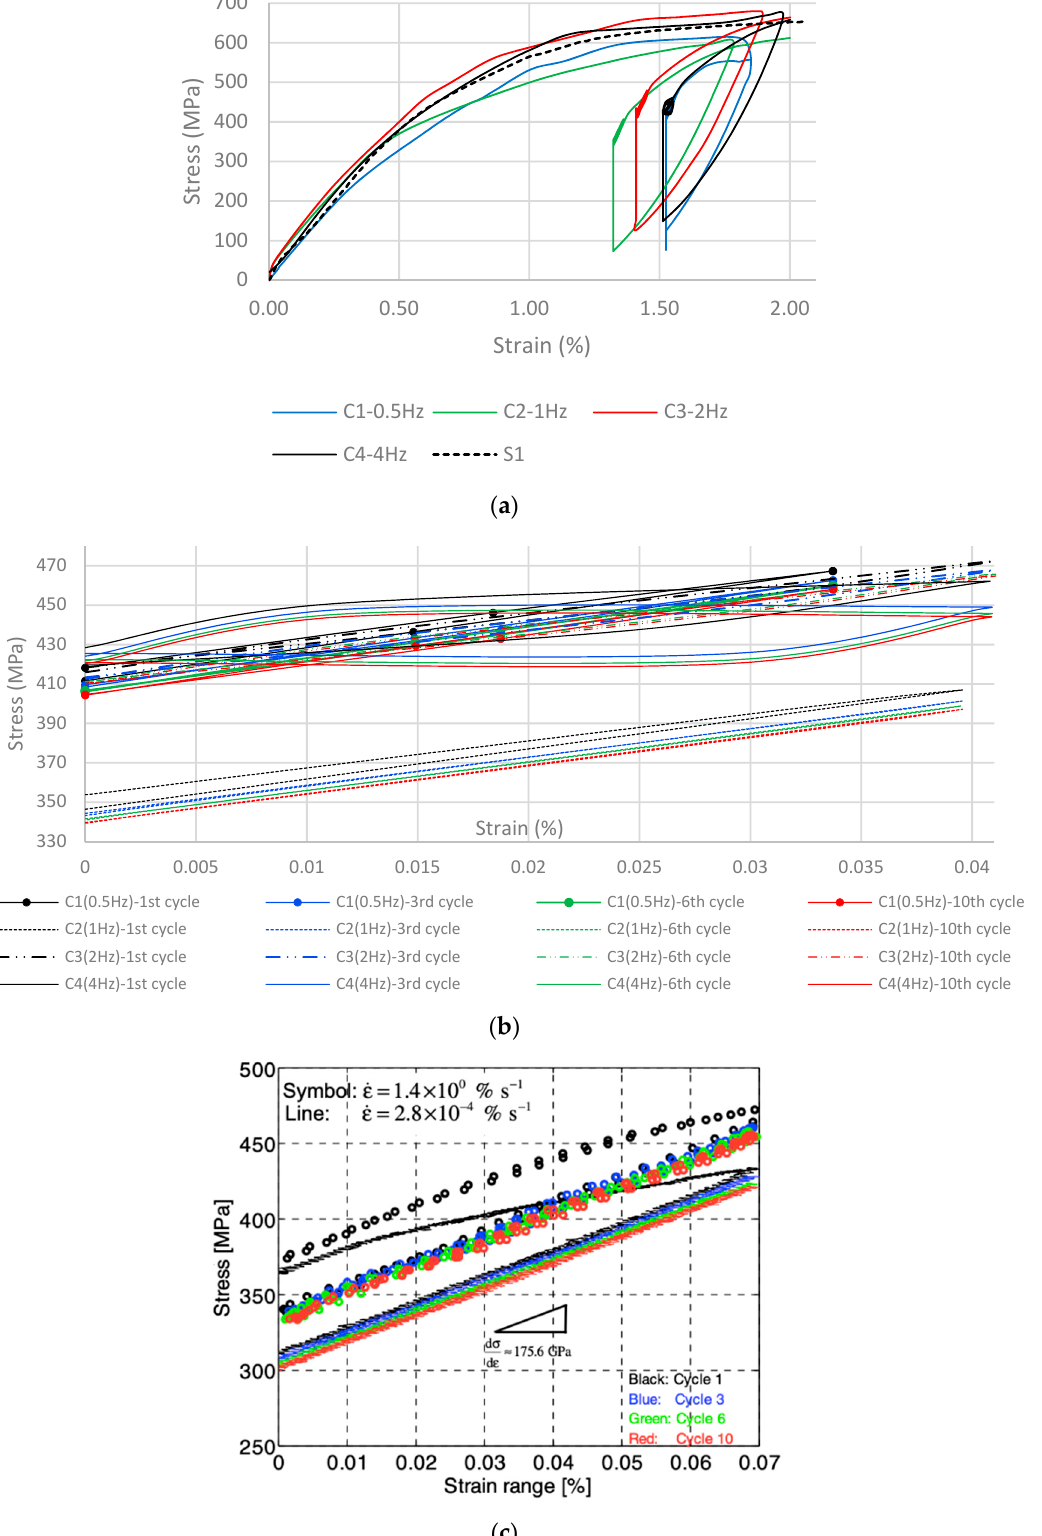
Figure 9. ( a ) Fatigue tests results. ( b ) Detailed graph of the alloy’s cyclic behavior at the programmed strain range. ( c ) Ghafoori et al. [40]: detailed graph of the alloy’s cyclic behavior at the programmed strain range.